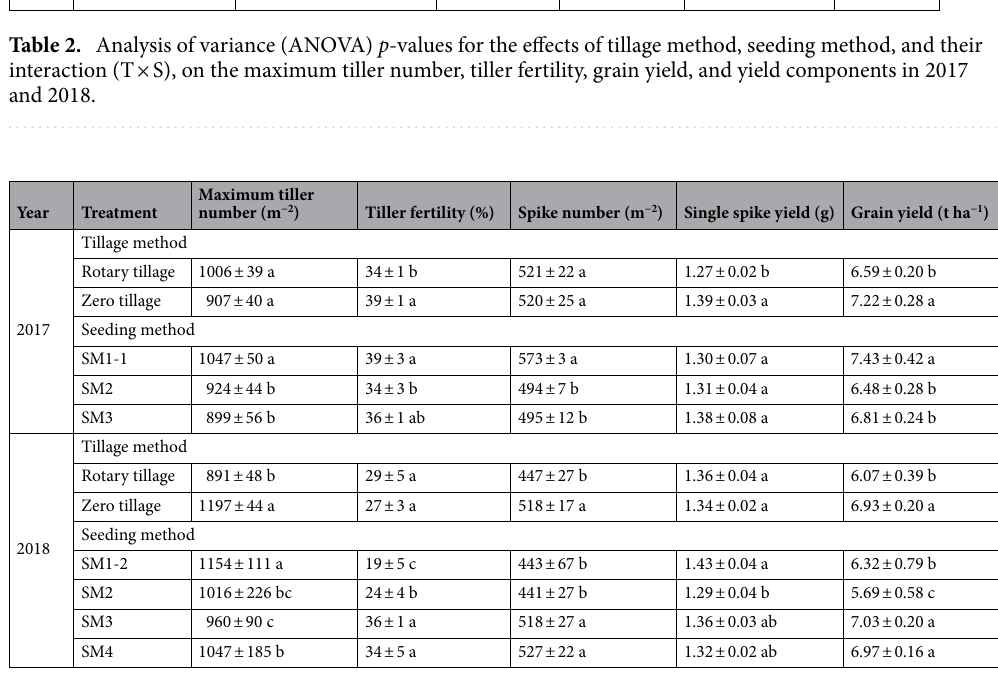
Table 3. The effects of the tillage method and seeding method on the maximum tiller number, tiller fertility, grain yield, and yield components in 2017 and 2018. Data are presented as means ± standard errors. Different letters indicate significant differences between treatments at the 0.05 probability level. SM1-1 small-size broadcast seeder, SM1-2 small-size drill seeder, SM2 small-size strip seeder, SM3 medium-size strip seeder, SM4 medium-size drill